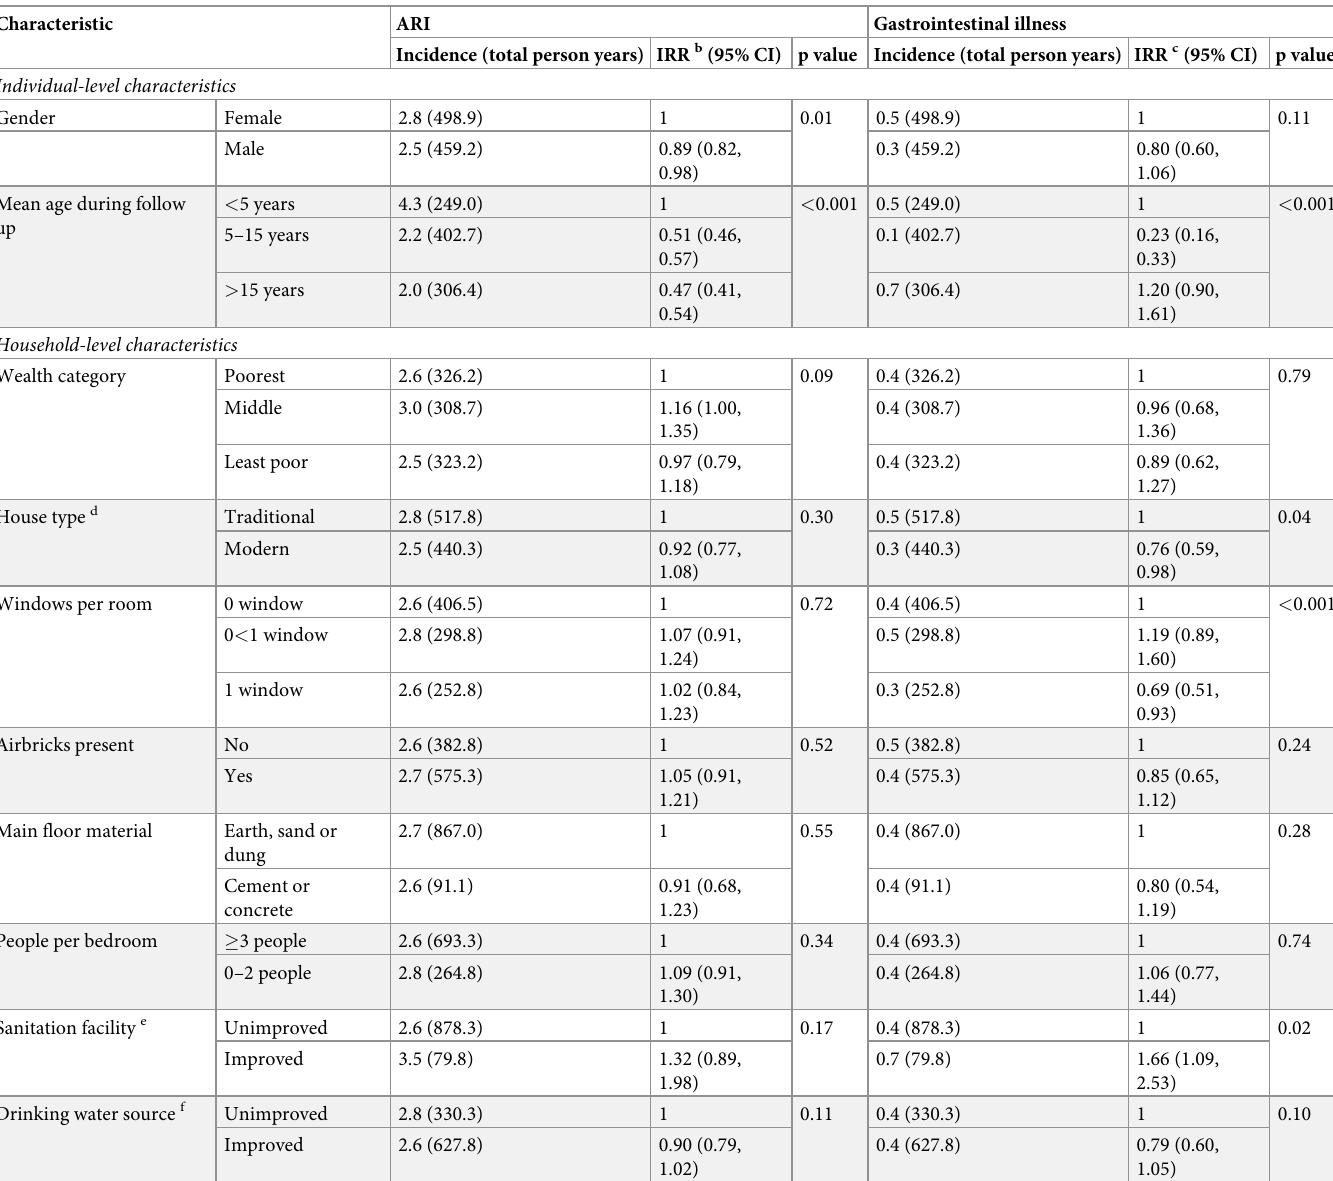
Table 4. Association between house type and incidence of acute respiratory infection and gastrointestinal illness in Nagongera, Uganda (adjusted results).